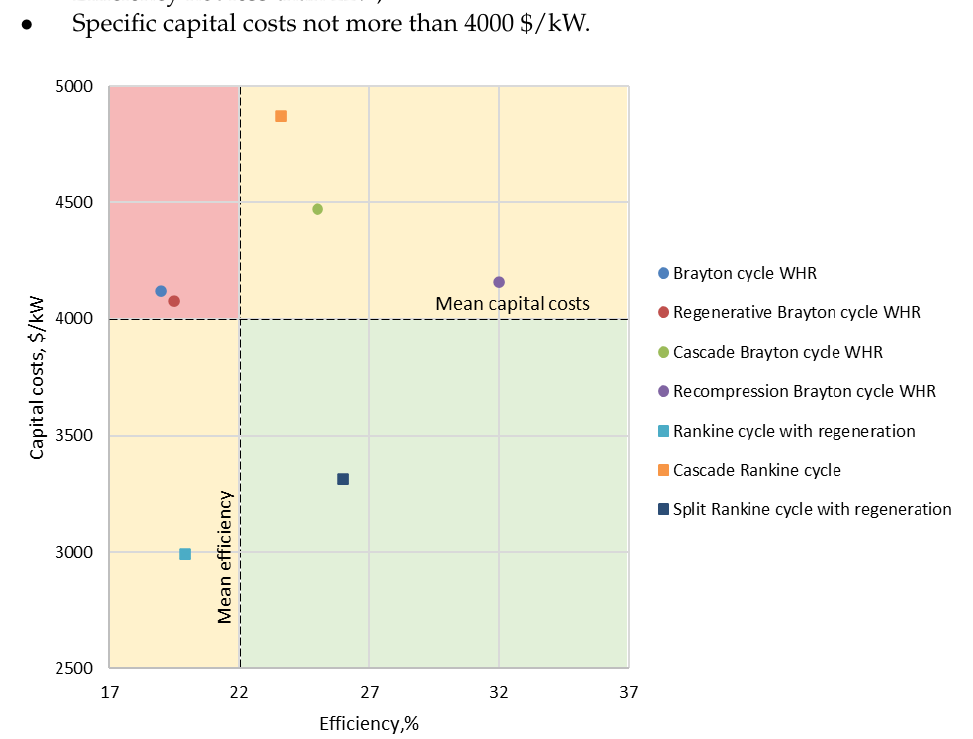
Figure 29. Technologies of CO 2 power cycles for small-capacity power engineering.